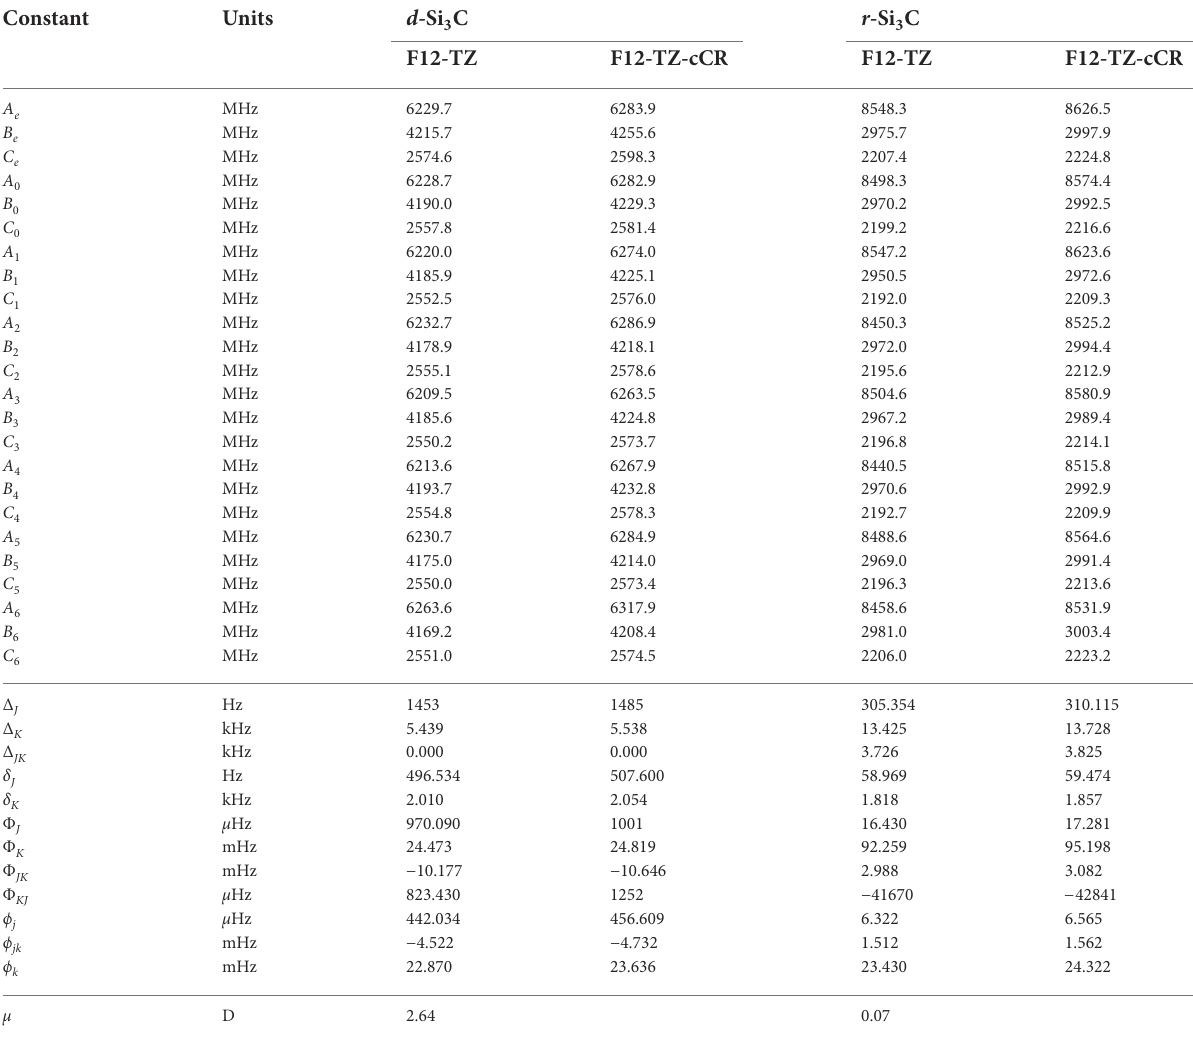
TABLE 8 Equilibrium( e ),vibrationally-averaged( 0 ),andsingly-vibrationallyexcited( n >0 )principalrotationalconstants,quartic( Δ / δ )andsextic( Φ / ϕ ) distortionconstants,anddipolemoments ( μ ) forSi 3 CIsomers.